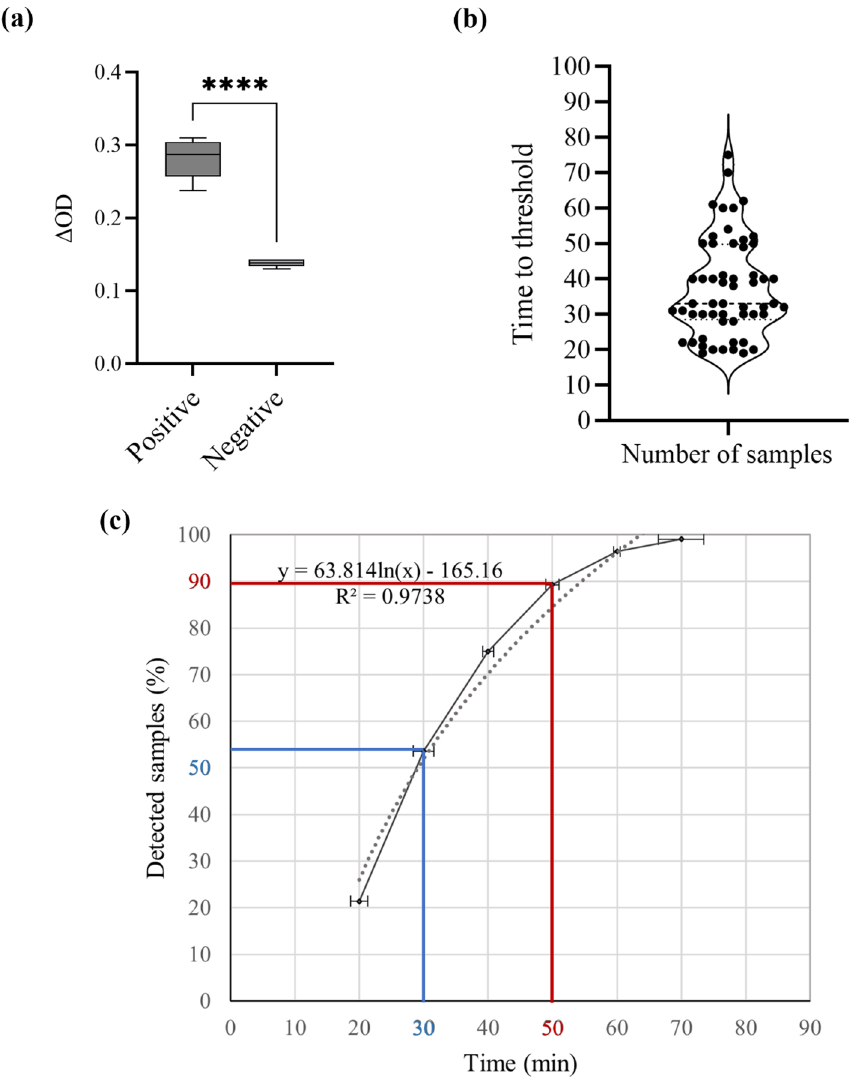
Figure 6. ( a ) Quantification of the color change between positive and negative samples by the spectrophotometric measurement of optical density (ΔOD) at 434 and 560 nm (n = 10). The line inside the box represents the median, and the whiskers extend to the maximum and minimum values. The four asterisks (*) correspond to p < 0.0001, which is a statistically significant difference (unpaired t test, p < 0.05, 95% CI). ( b ) Time to the detection threshold of all positive samples. The dashed line indicates the median detection time (33 min). ( c ) Percentage of total positive samples detected plotted against time. All samples (100%) were detected into 75 min. In addition, 90% of the SARS-CoV-2 positive specimens were diagnosed in 50